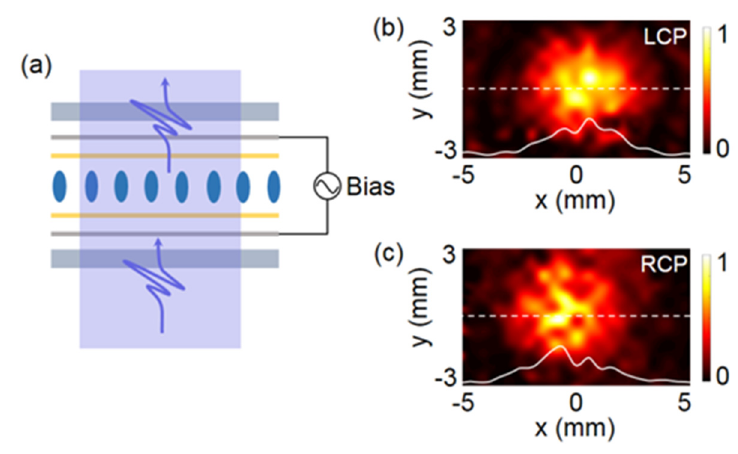
Figure 6. Results obtained after a saturation voltage is applied: ( a ) switchable function of the device; ( b , c ) far-field intensity distributions in the xy -plane under ( b ) LCP and ( c ) RCP incidence. The white solid line shows the horizontal intensity distribution along the white dashed line.